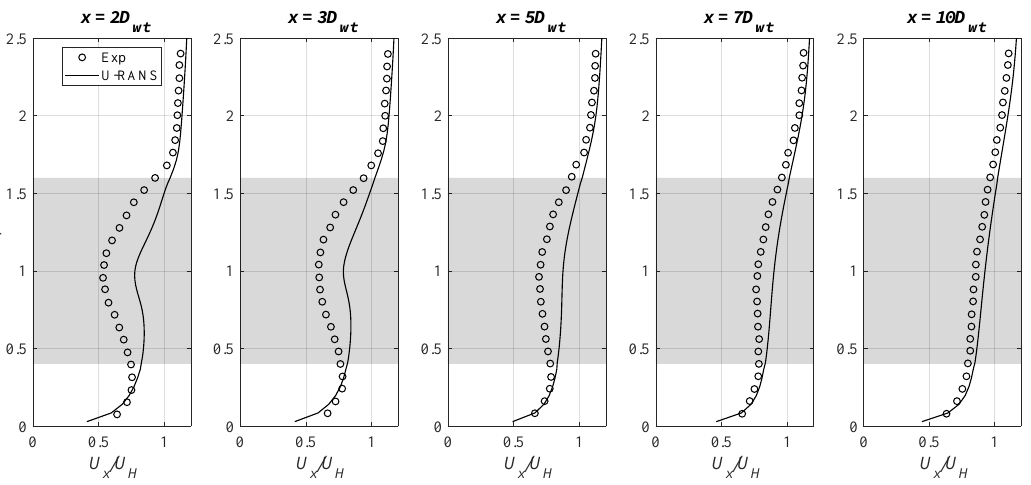
Figure 14. Vertical profiles of mean velocity normalized with the hub-height velocity at different stream-wise locations downstream of the turbine taken from the midplane (the shaded region depicts the rotor area)